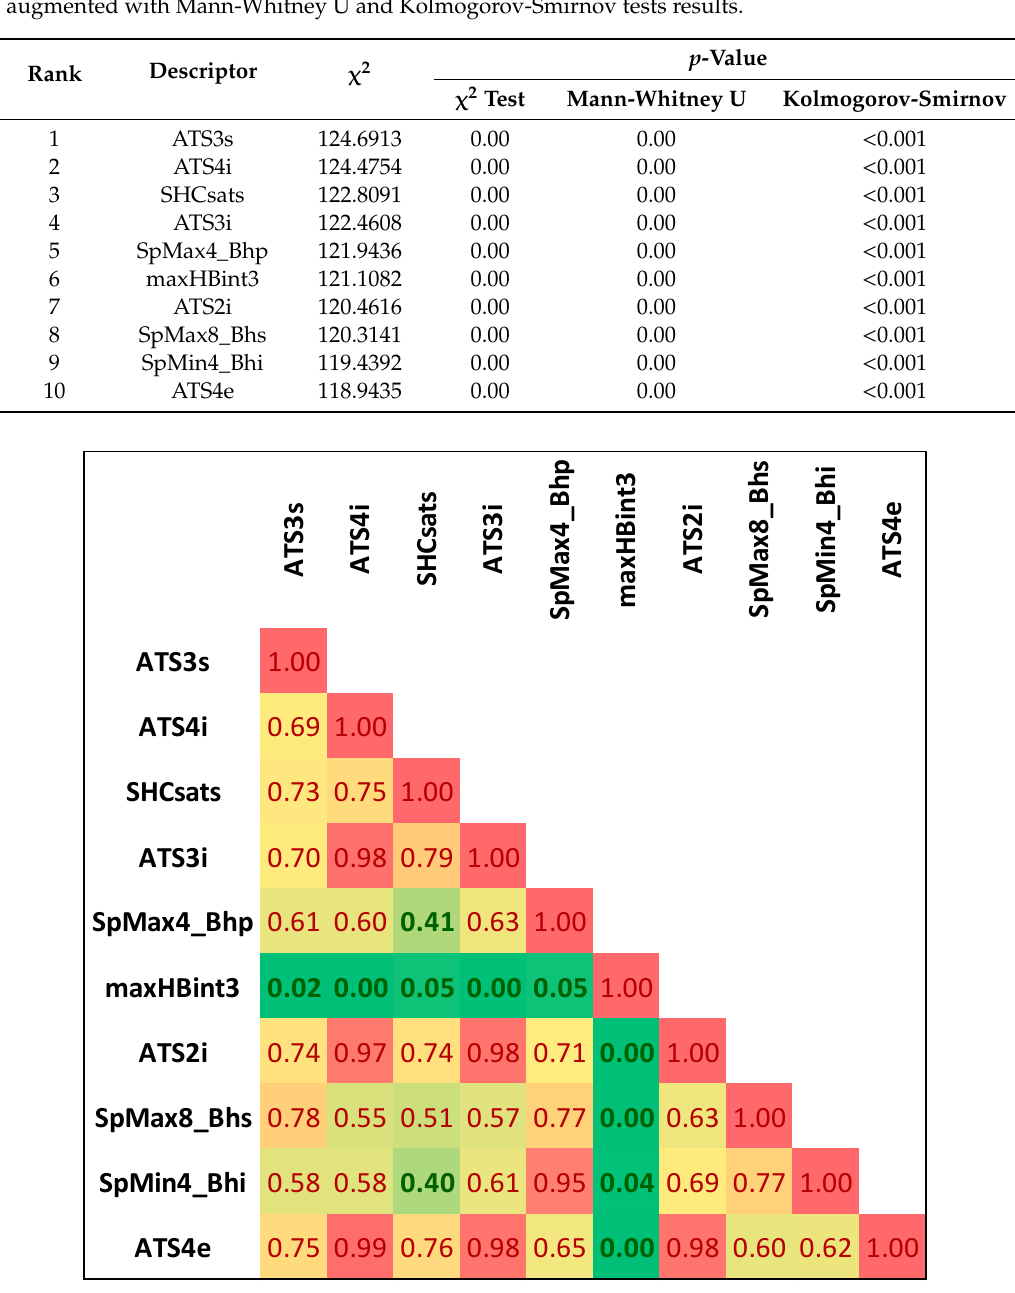
Table 1. The list of selected descriptors with the aid of the χ 2 ranking approach. The analysis was augmented with Mann-Whitney U and Kolmogorov-Smirnov tests results.